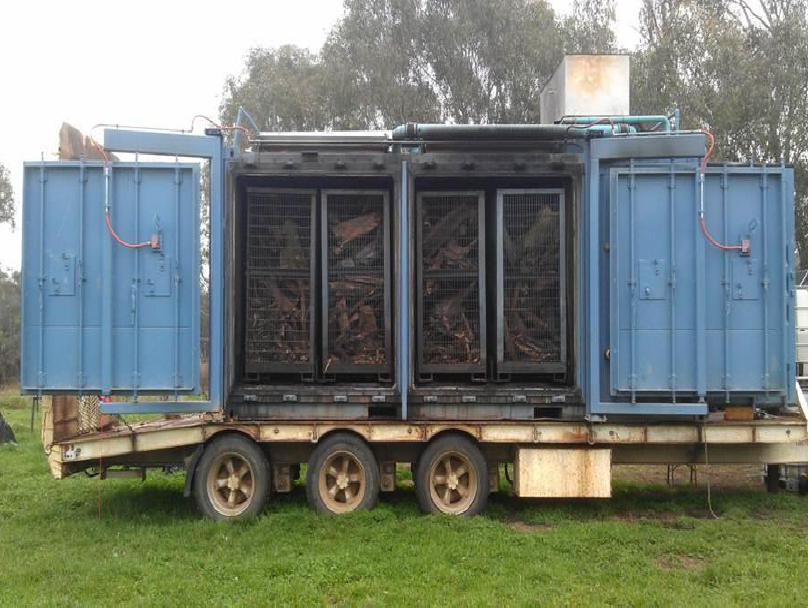
Figure 2. CharMaker commercial facility used for pyrolysing biosolids in this study.